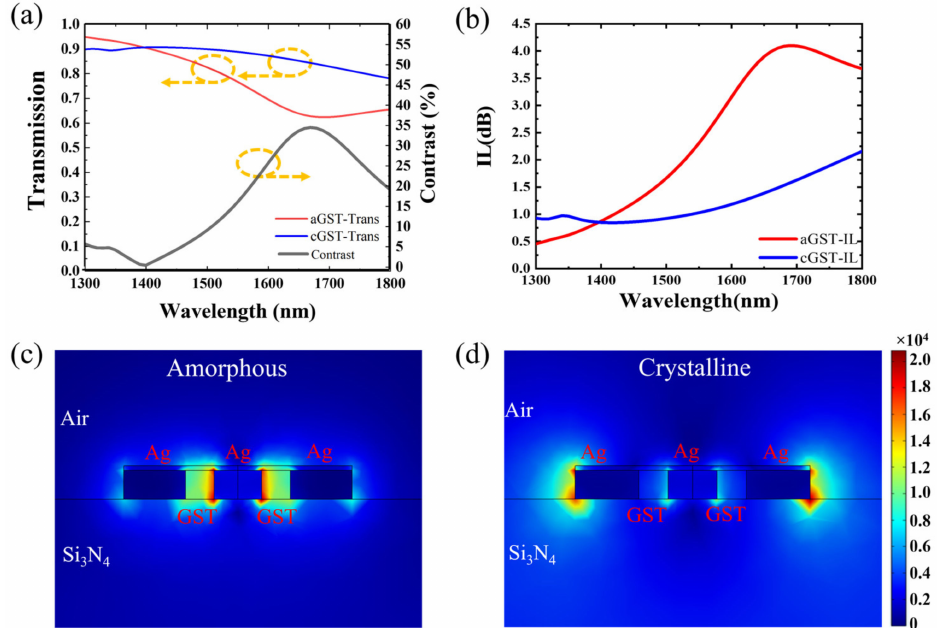
Figure 4. ( a ) Spectral response of the plasmonic phase-change device. ( b ) Insertion loss curves of the device in crystalline and amorphous states. Electric field diagram of the device in the ( c ) amorphous and ( d ) crystalline